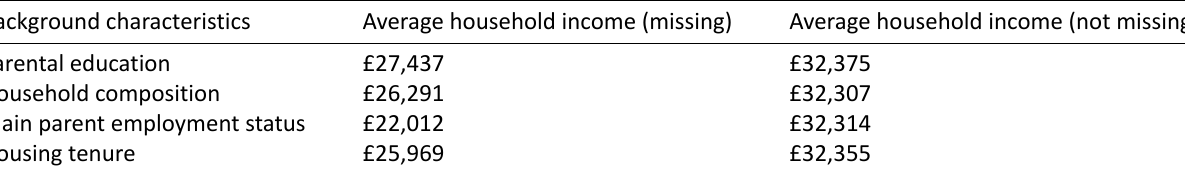
Table 2. The difference in household annual income missing or not-missing background data in wave 1 of Next Steps.